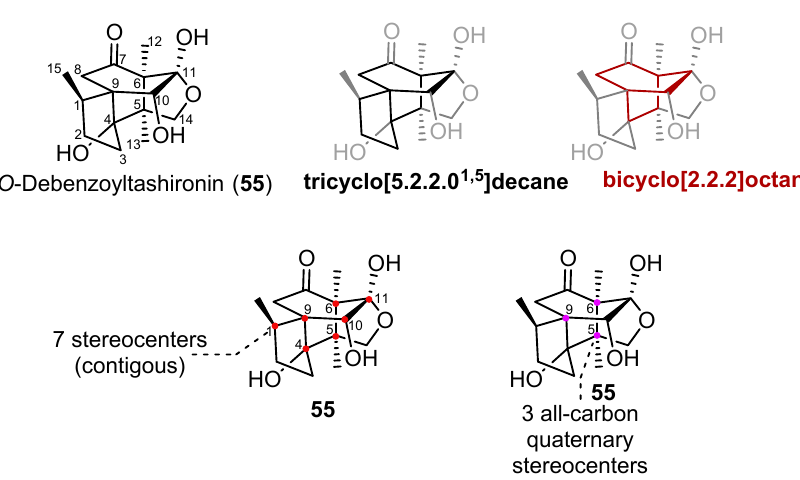
Figure 6. Rings systems and stereocenters of 11- O -debenzoyltashironin ( 55 ).